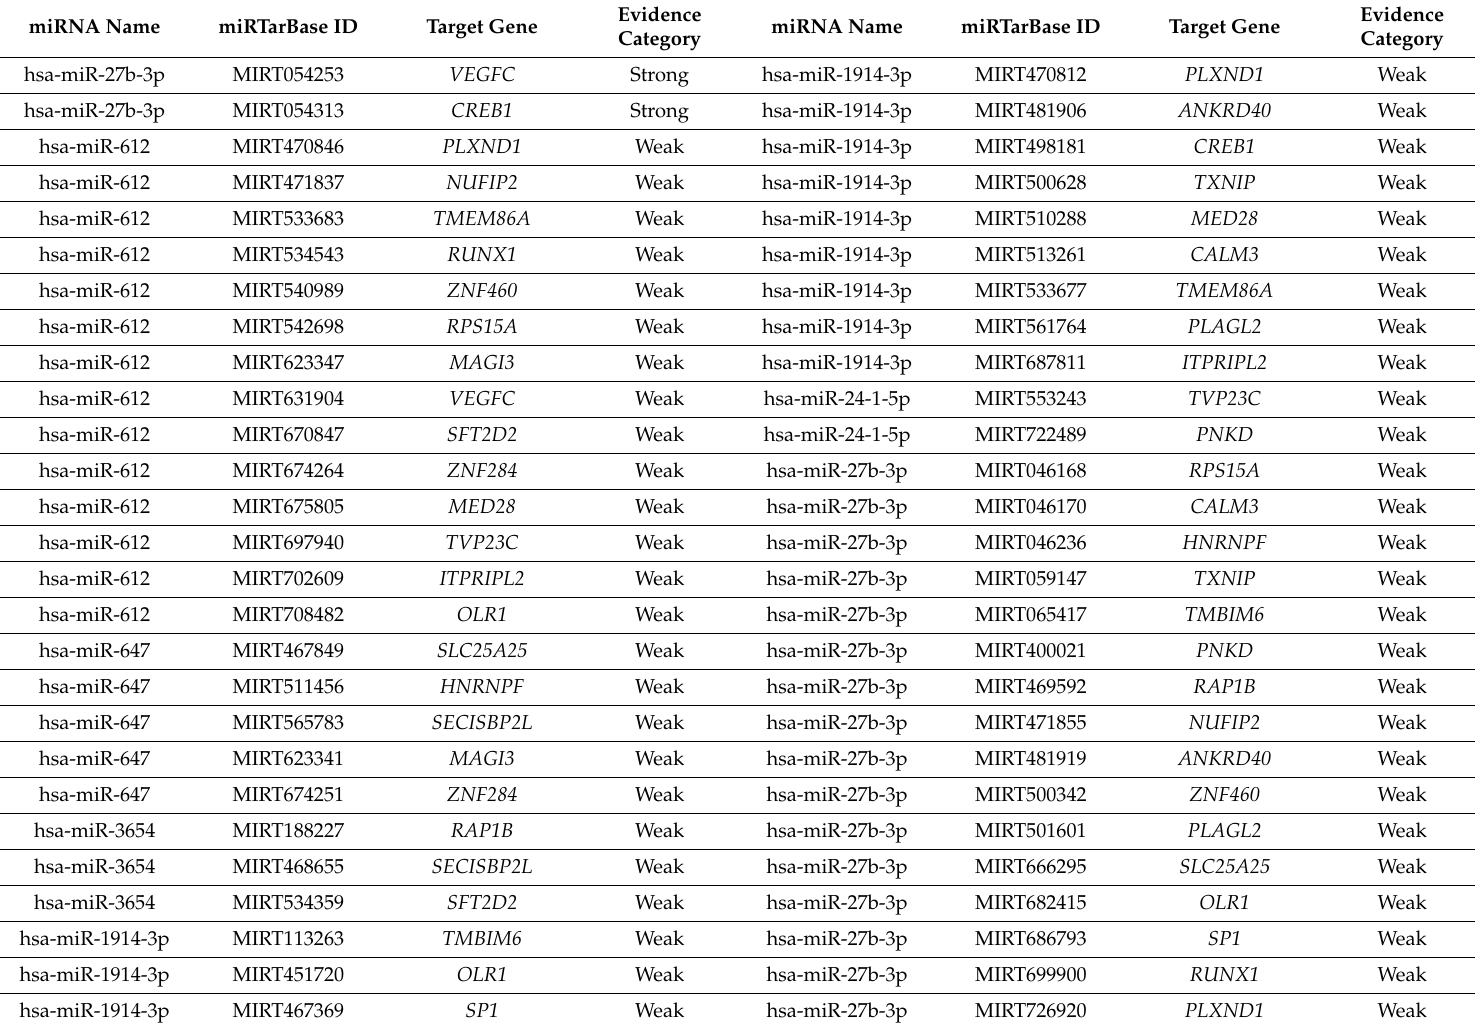
Table 2. List of overlapping target genes between the 6 candidate